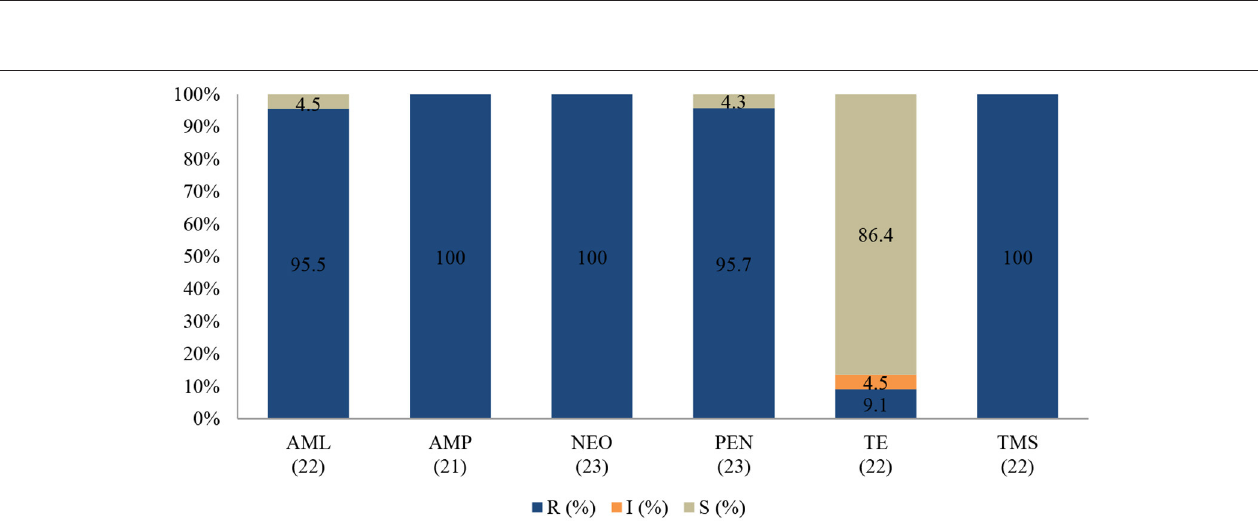
FIGURE 3 | Antibiotic susceptibility pattern of Staphylococcus aureus isolates from diseased ruminants (January 2015-December 2017) R-resistance; I-intermediate; S-susceptible; AMC-amoxicillin/clavulanic acid; AML-amoxicillin; AMP-ampicillin; CN-gentamicin; ENO-enrofloxacin; NEO-neomycin; PEN-penicillin; STR-streptomycin; TE-tetracycline; TMS-trimethoprim/sulfamethoxazole; Numbers inside brackets “()” indicate total number of tested isolates for each antibiotic.